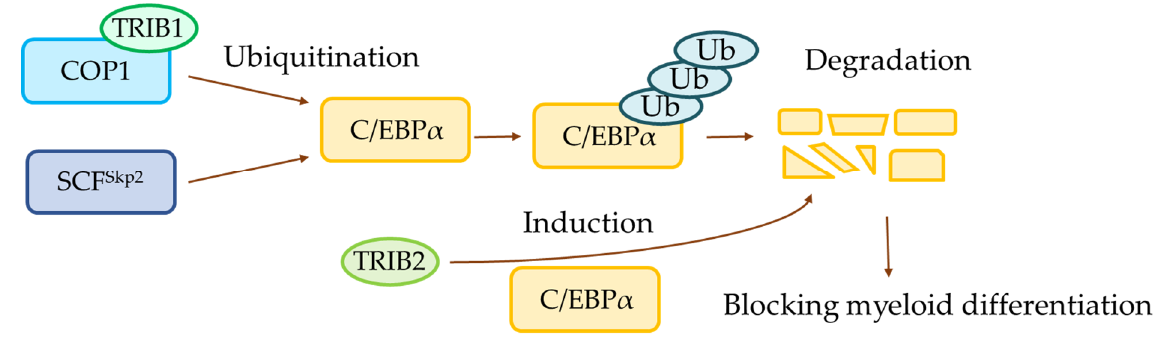
Figure 3. Schematic diagram of the C/EBPα signaling pathway. TRIB1 binds to COP1 and enhances its ubiquitin ligase activity. COP1 and SCF Skp2 ubiquitinate and induce proteasomal degradation of FLT3-ITD. TRIB2 binds and promotes proteasome-dependent C/EBPα degradation.